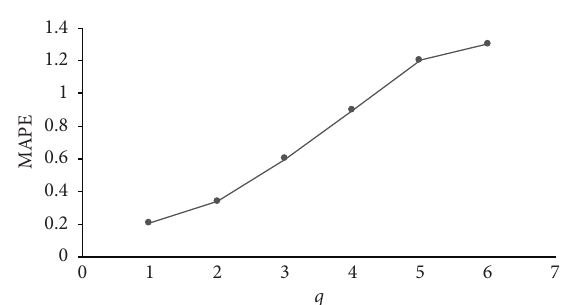
Figure 3: Effect of parameter q on model.